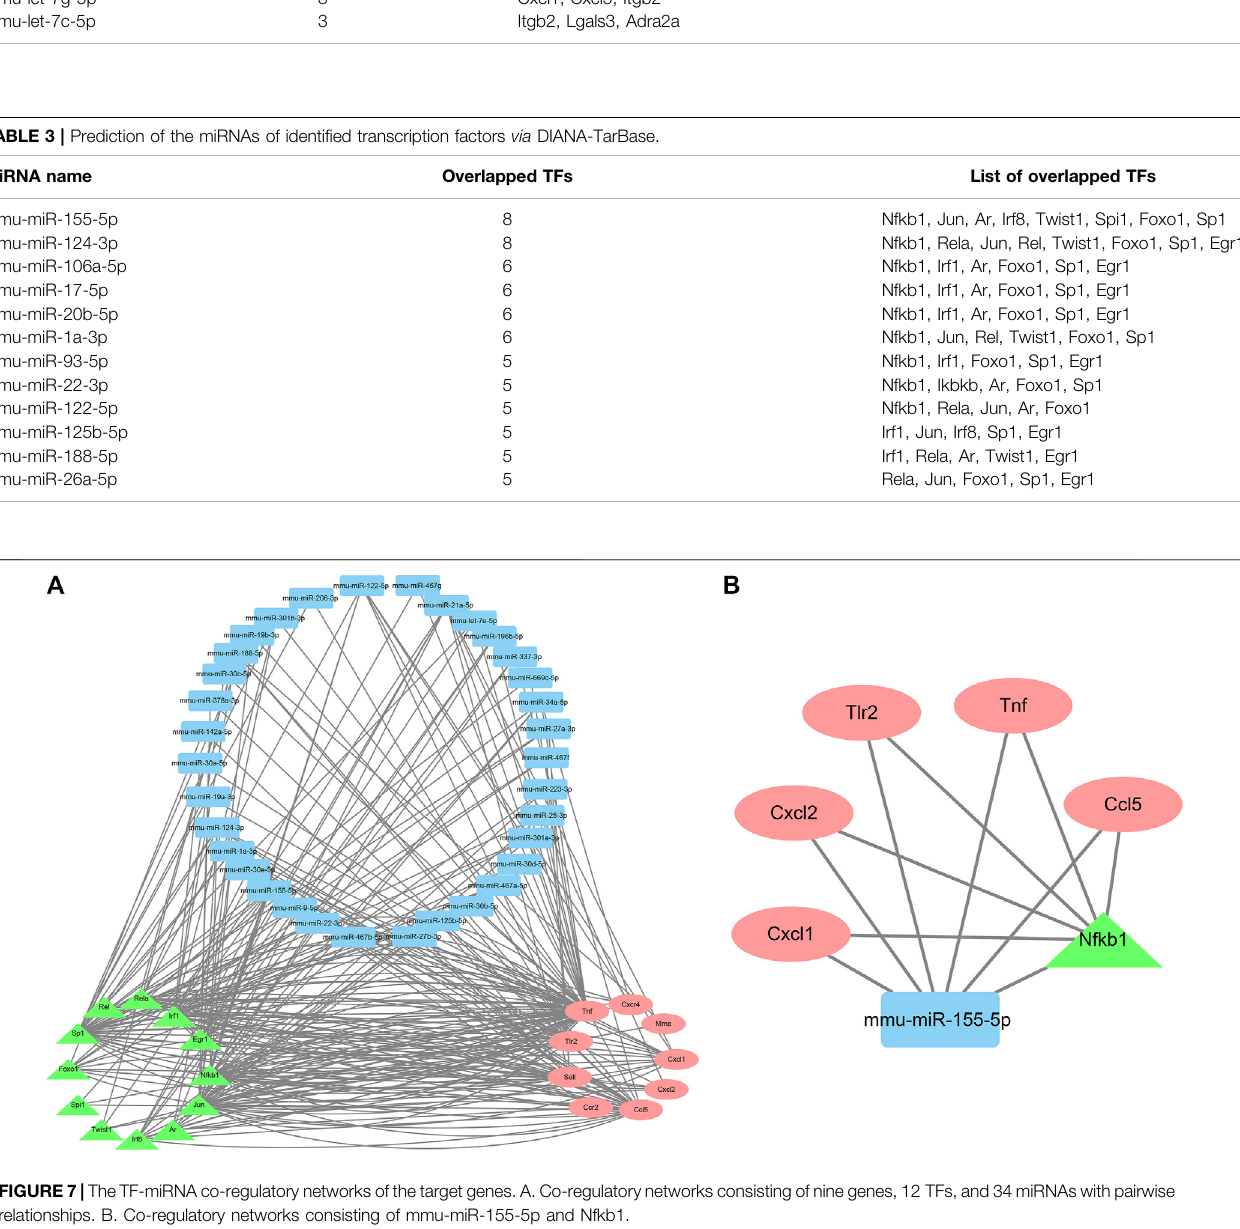
Frontiers in Molecular Biosciences |